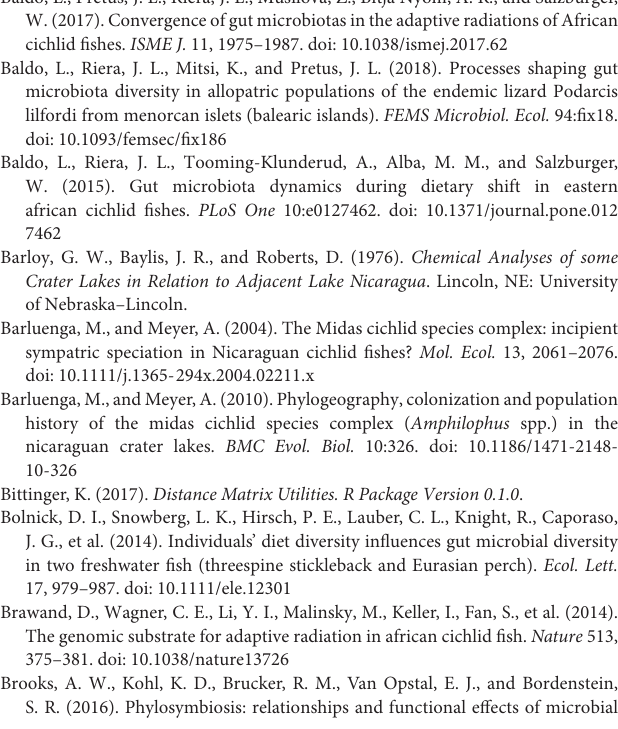
TABLE S1 | Sample metadata. TABLE S2 | Filtering process in mothur.